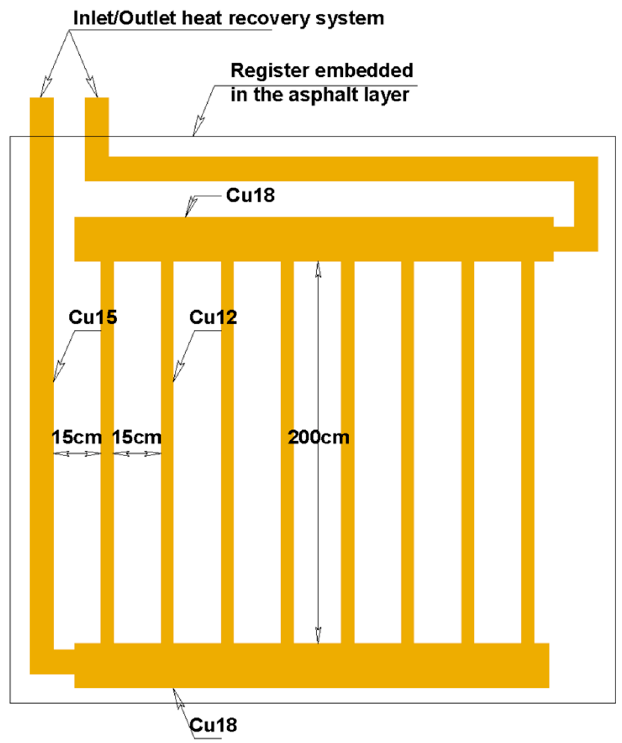
Figure 1. Heat recovery register geometry.